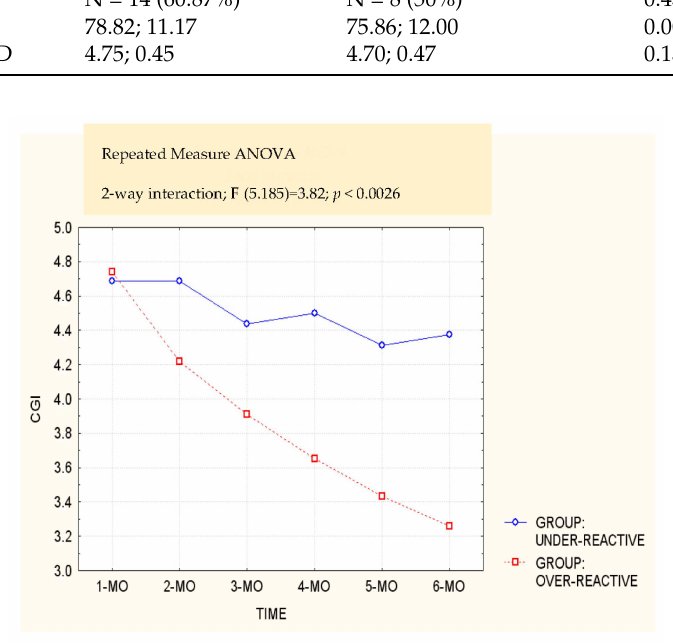
Figure 1. CGI mean score in the 4 measurements during